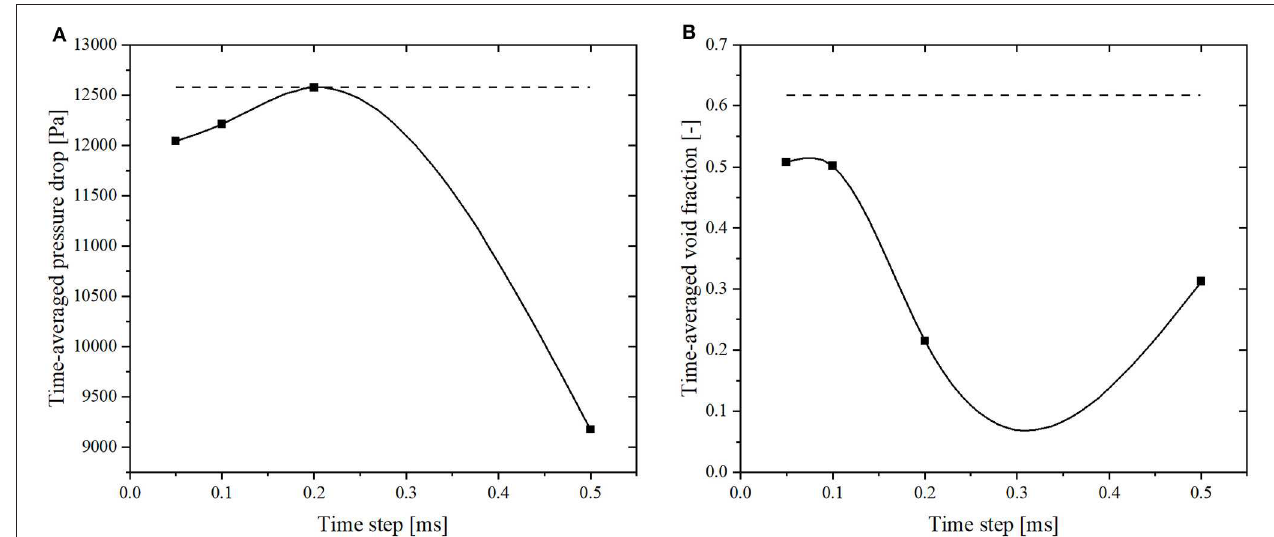
FIGURE 5 | Results of the time step convergence study. (A) Two-phase pressure drop. (B) Void fraction.